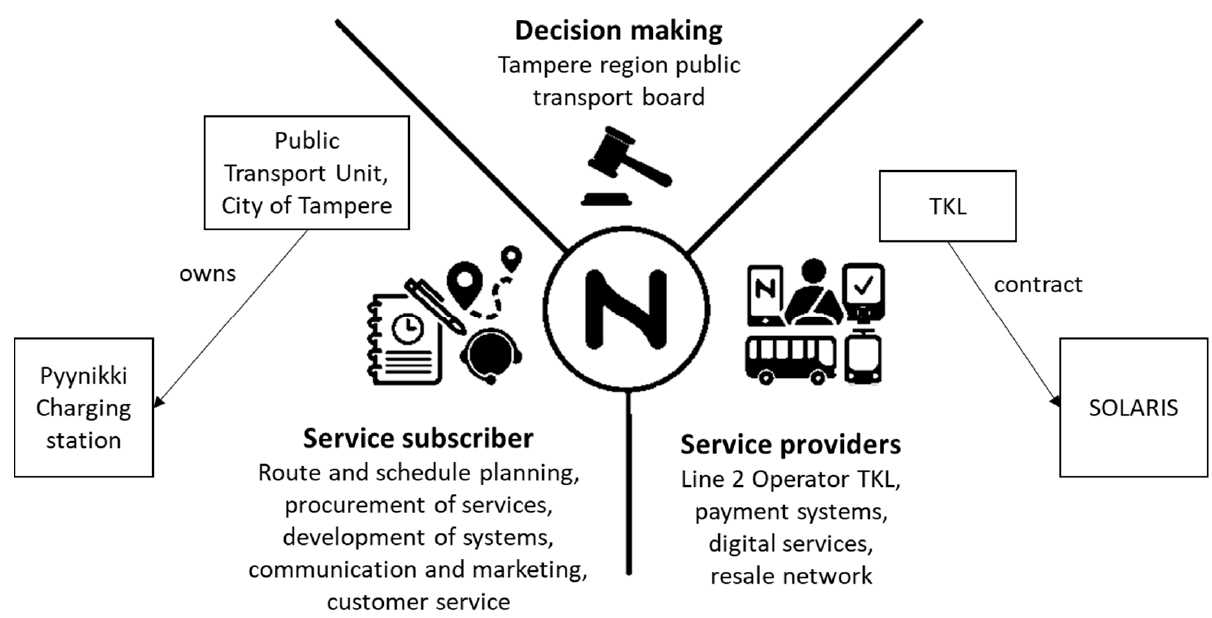
Figure 2. The parties involved in preparing and implementing the electric busses’ acquisition.